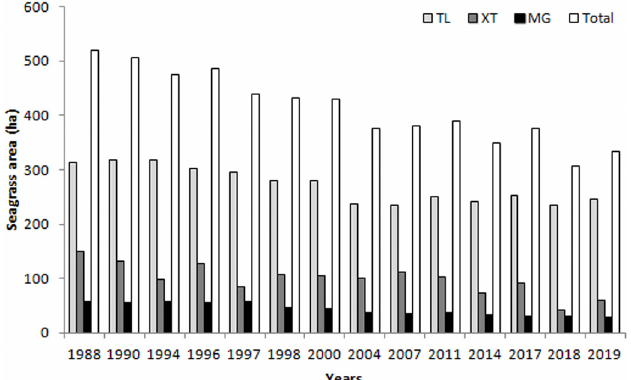
Fig. 6. Change detection of seagrass beds at TL (25% solid background), XT (50% solid background), MG (100% solid background) and the total (blank) 1988 to 2019. See Fig. 1 for the abbreviation of